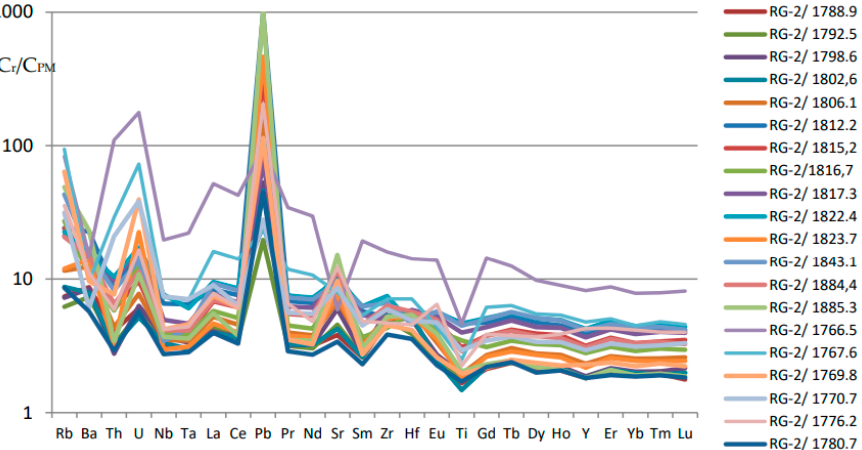
Figure 6. Spider-diagram for intrusive rocks penetrated by borehole RG-2. Normalized to primitive mantle after [40]. Data in Table 1.